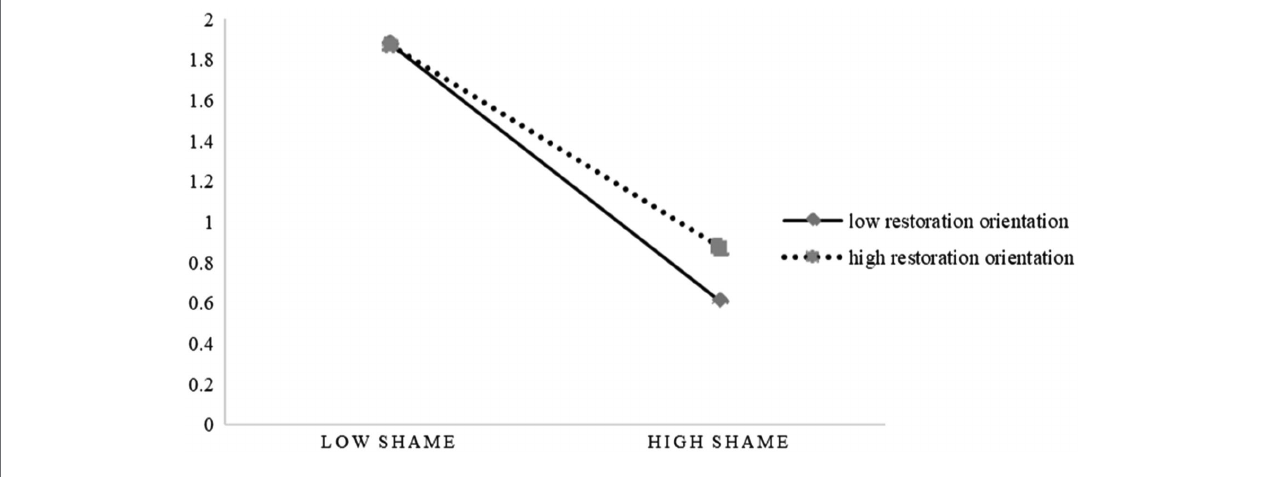
FIGURE 3 | The moderating role of restoration